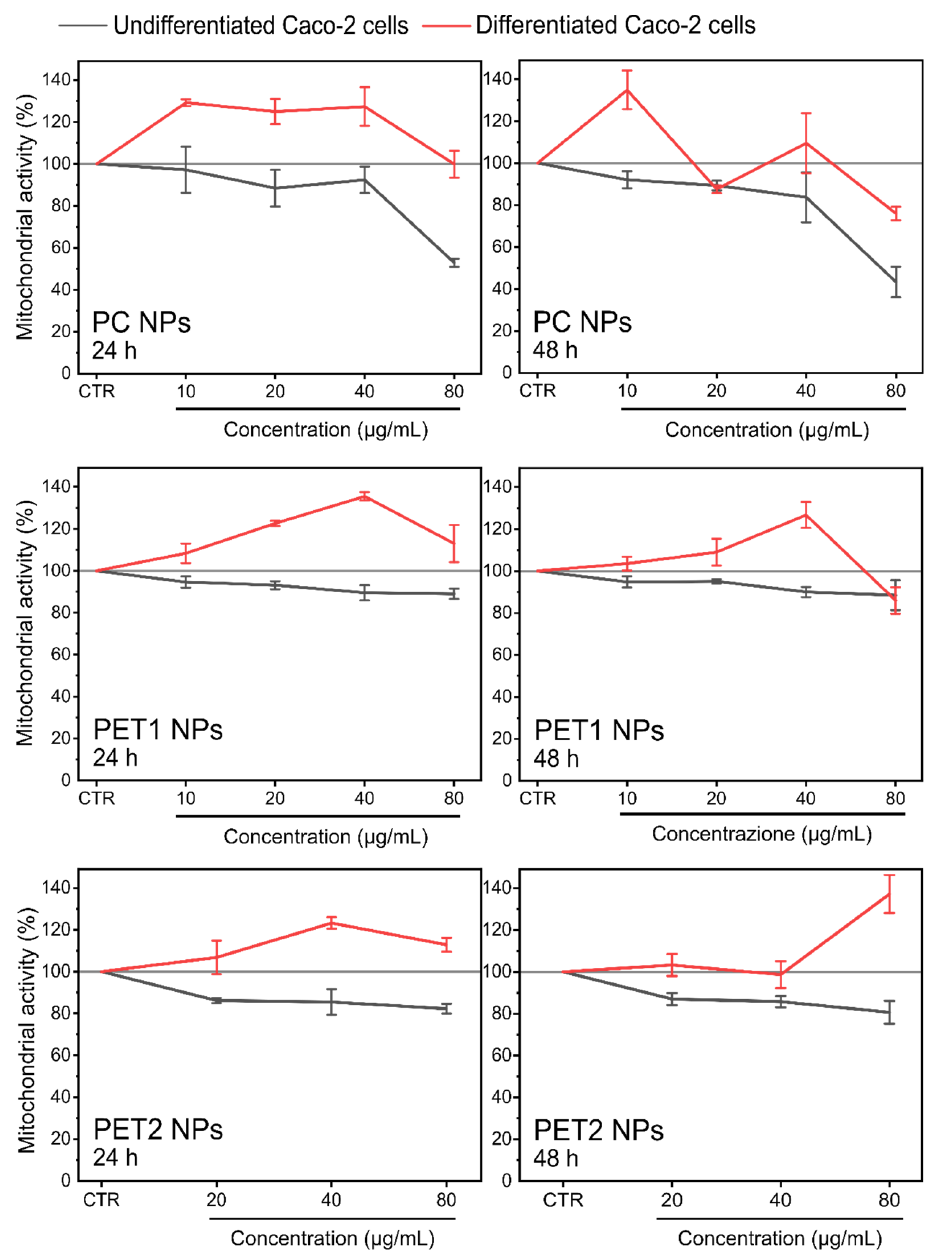
Figure 9. Mitochondrial activity of undifferentiated and differentiated Caco-2 cells exposed to different doses of PC, PET1 or PET2 NPs for 24 or 48 h. Data are expressed as percentage of mitochondrial activity normalized to the control (untreated cells) and reported as the mean of three independent experiments (run in triplicate) ± SD.